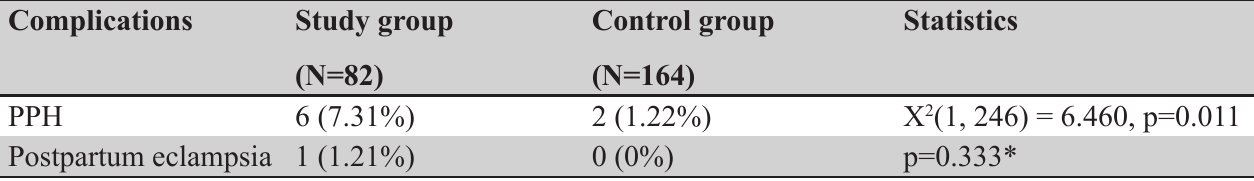
Table 3. Comparison of postpartum complications between the groups.